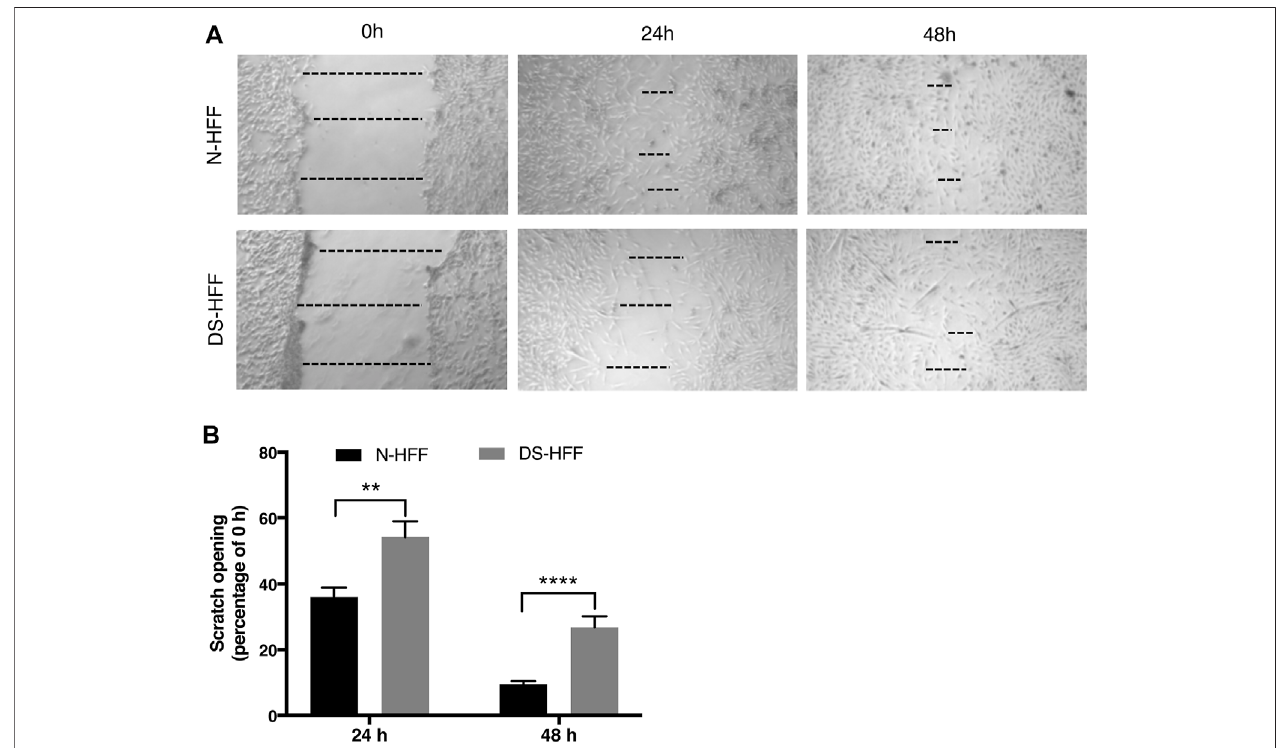
FIGURE7| CellmigrationiscompromisedinDS-HFFs.Therateofmigrationwasmeasuredbyquantifying,indifferentpoints,thedistanceofthearealackingcells. (A) Representative images of N-HFF and DS-HFF scratch opening at 0, 24, and 48 h. The dotted lines de fi ne the area lacking cells (wound area, ImageJ). (B) Scratch opening quanti fi cation. Mean values ± SEM from four euploid and four trisomic samples are represented as percentage of scratch opening at 0 h. ** p -value ≤ 0.01, **** p -value ≤ 0.0001.